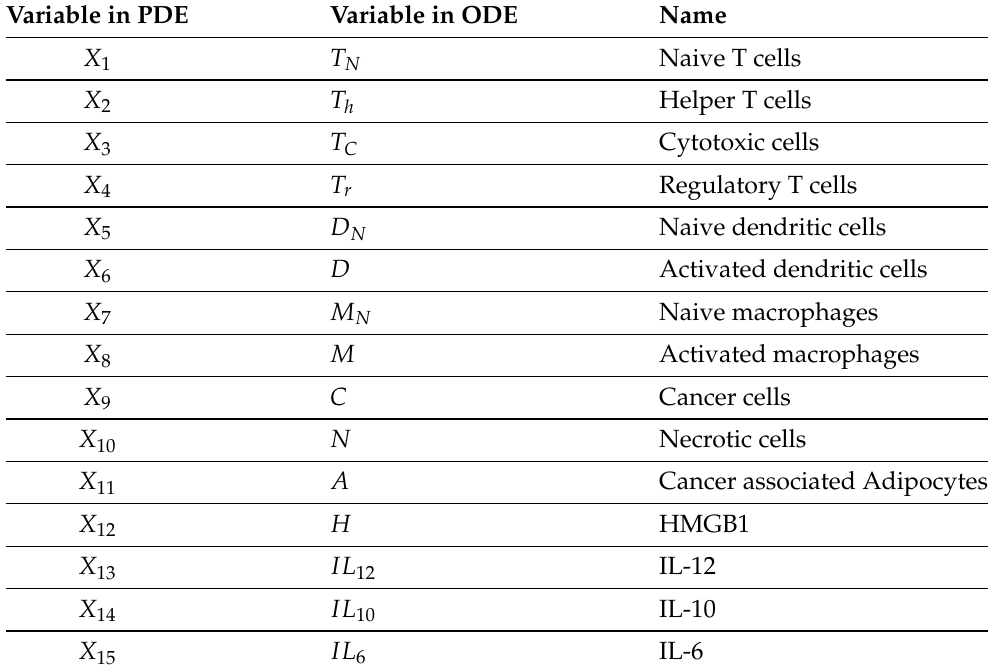
Table 1. PDE and ODE variables. This table shows the relationship between the variables from (1) and the system of ODEs in